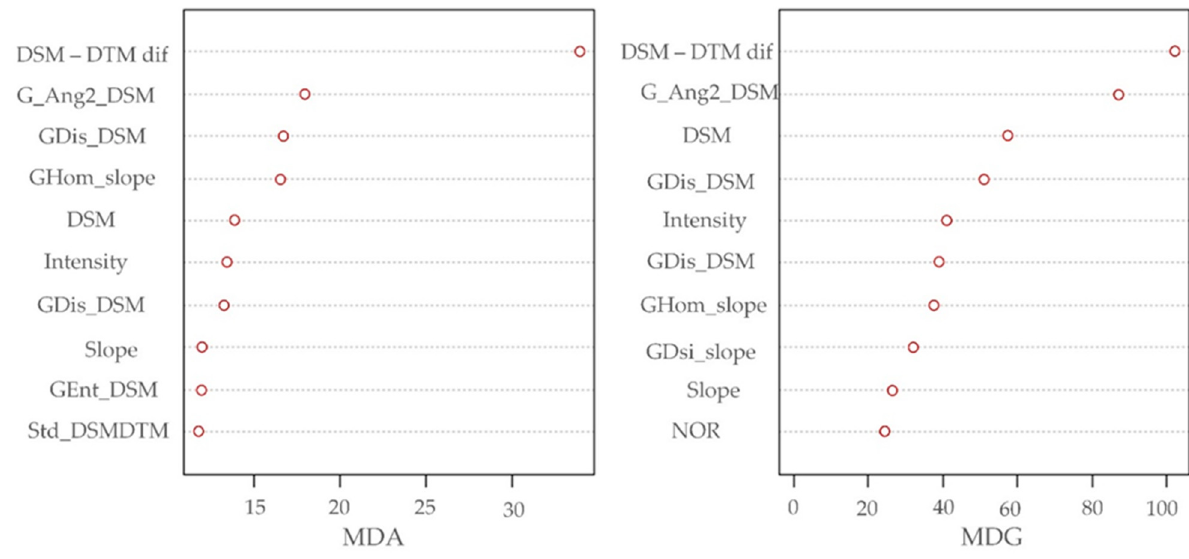
Figure 7. Top 10 variable selection with 70%–30% training–testing data split.